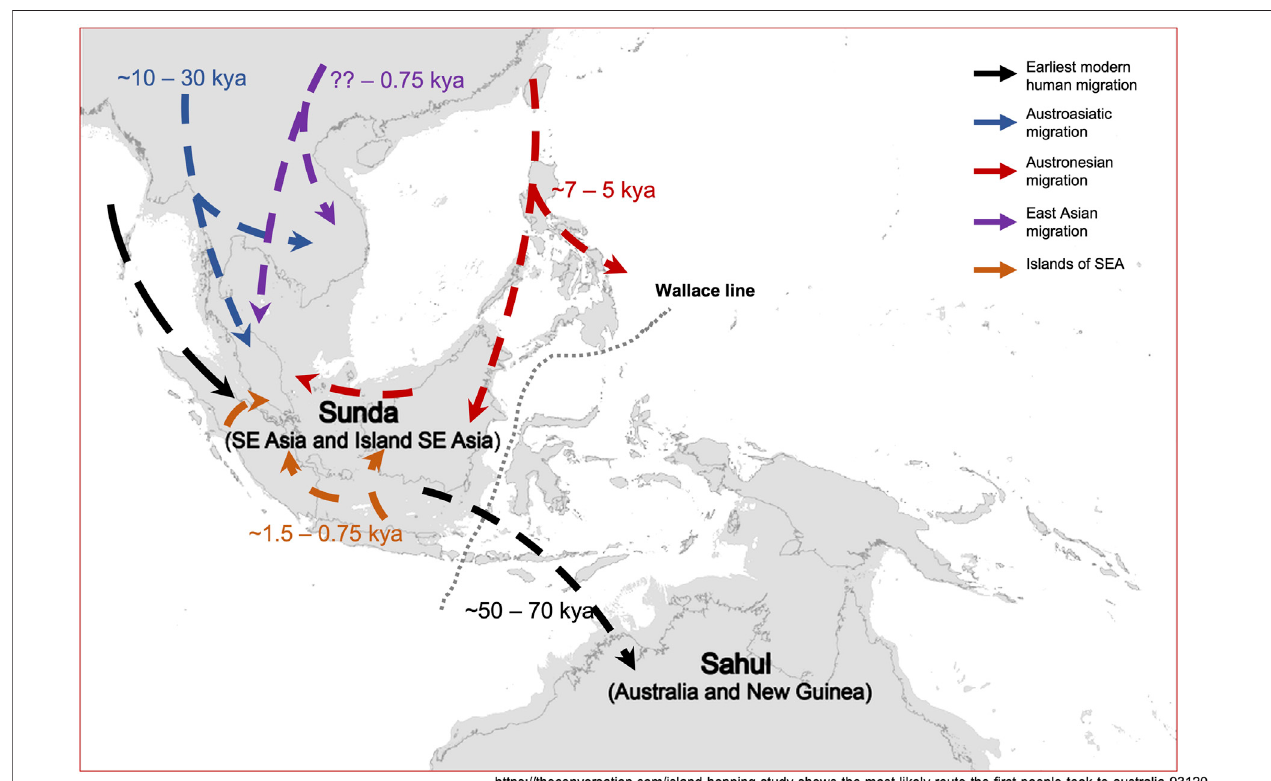
FIGURE 4 | A hypothetical model of migration history of the native populations from Malaysia. The map was adapted and modi fi ed from https://theconversation. com/island-hopping-study-shows-the-most-likely-route-the- fi rst-people-took-to-australia-93120, with permission.